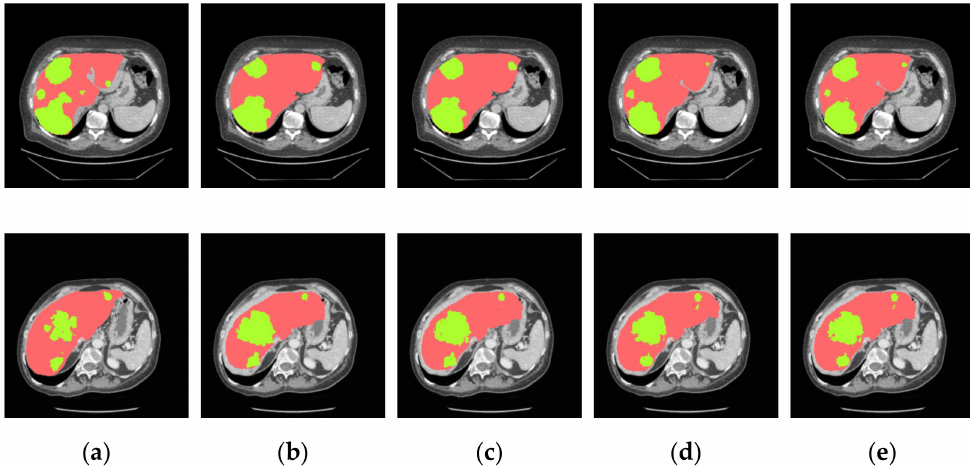
Figure 8. Segmentation results for the liver and tumors of pattern three. ( a ) Ground truths, ( b ) U-Net, ( c ) U-Net + ADenseNet1, ( d ) U-Net + ADenseNet2 and ( e ) cascaded